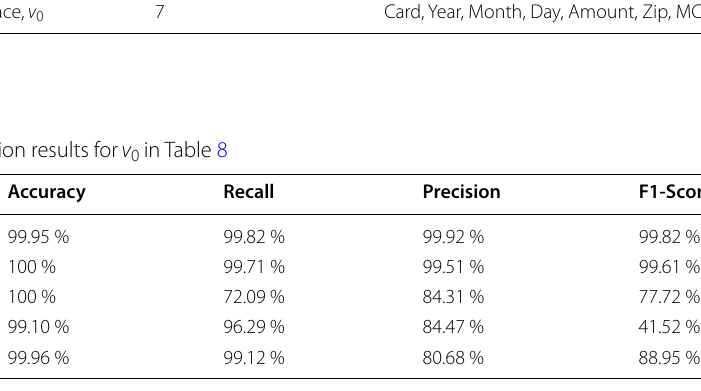
Table 10 GA Selected features—synthetic dataset Attribute vector